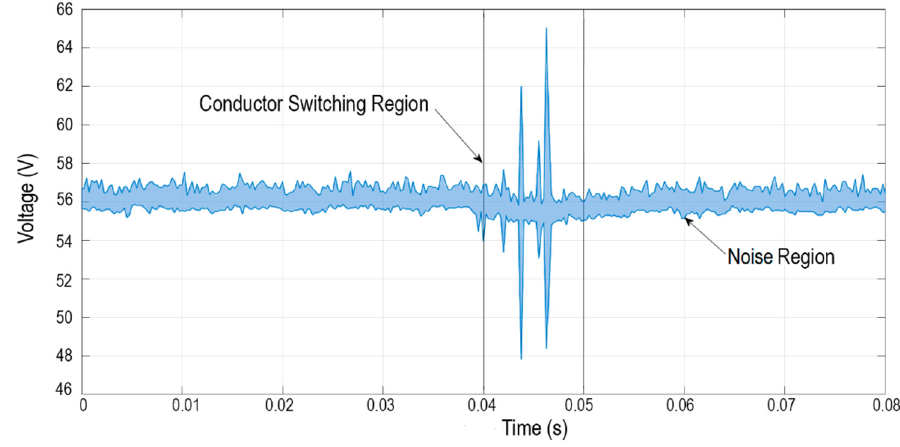
Figure 11. Voltage on the receiving end. Output capacitor capacitance is 1880 μ F.